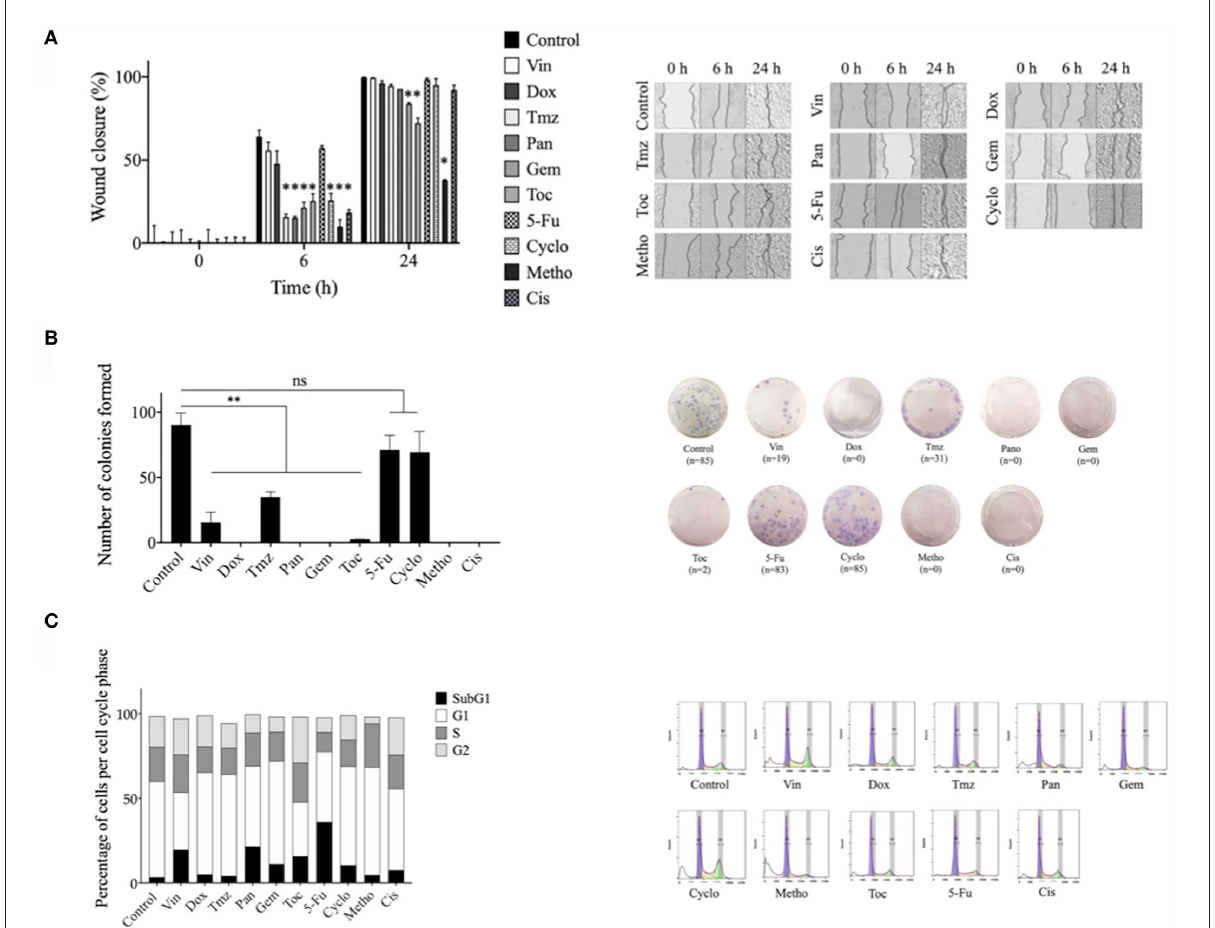
FIGURE2 Effect of different pharmacological agents on the migration, colony formation, and cell cycle arrest of the CTVT cell line. (A) Wound healing assay with CTVT cells treated with the CC 50 of Vin, Dox, Tmz, Pan, Gem, Toc, 5-Fu, Cyclo, Metho, and Cis for 24h. The graph bar represents the wound closure percentage of three replicates ± SD and the image shows representative photographs taken under bright field microscope at a 40 × magnification at the 0, 6, and 24h time points. (B) Colony formation assay of CTVT cells treated with the CC 50 of Vin, Dox, Tmz, Pan, Gem, Toc, 5-Fu, Cyclo, Metho, and Cis for 24h, and then incubated with cell culture media for 21 days. The graph bar represents the number of colonies formed by three replicates ± SD and the image shows representative photographs of the colonies formed. (C) Cell cycle analysis of CTVT cells treated with the CC 50 of Vin, Dox, Tmz, Pan, Gem, Toc, 5-Fu, Cyclo, Metho, and Cis for 24h, as determined by flow cytometry. The graph bar represents the percentage of cells in each cell cycle stage (SubG1, G1, S, and G2), and representative cell cycle distribution histograms are also shown. Statistical significance was performed using Dunnet’s post hoc test (* p > / = 0.05). Vin, vincristine; Dox, doxorubicin; Tmz, temozolamide; Pan, panobinostat; Gem, gemcitabine; Toc, toceranib; 5-Fu, 5-fluorouracil; Cyclo, cyclophosphamide; Metho, methotrexate; Cis,